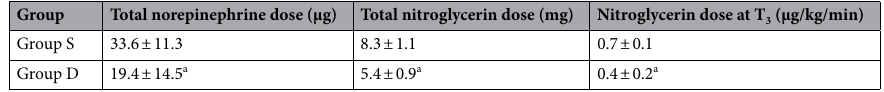
Table 4. Comparison of intraoperative vasoactive drug use between the two groups ( x ± s). Compared with the group S, a P < 0.05.